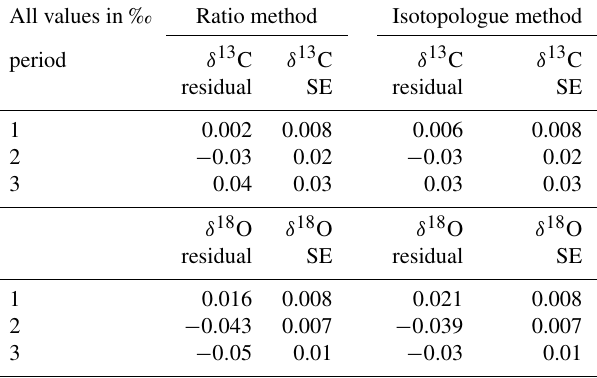
tope measurements on the SICAS are monitored by measure- ment of a quality control gas in every measurement sequence.